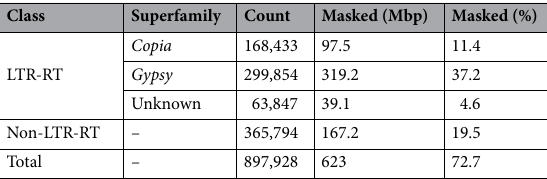
Table 4. Repeat elements in the O. australiensis KR scaffolds 51